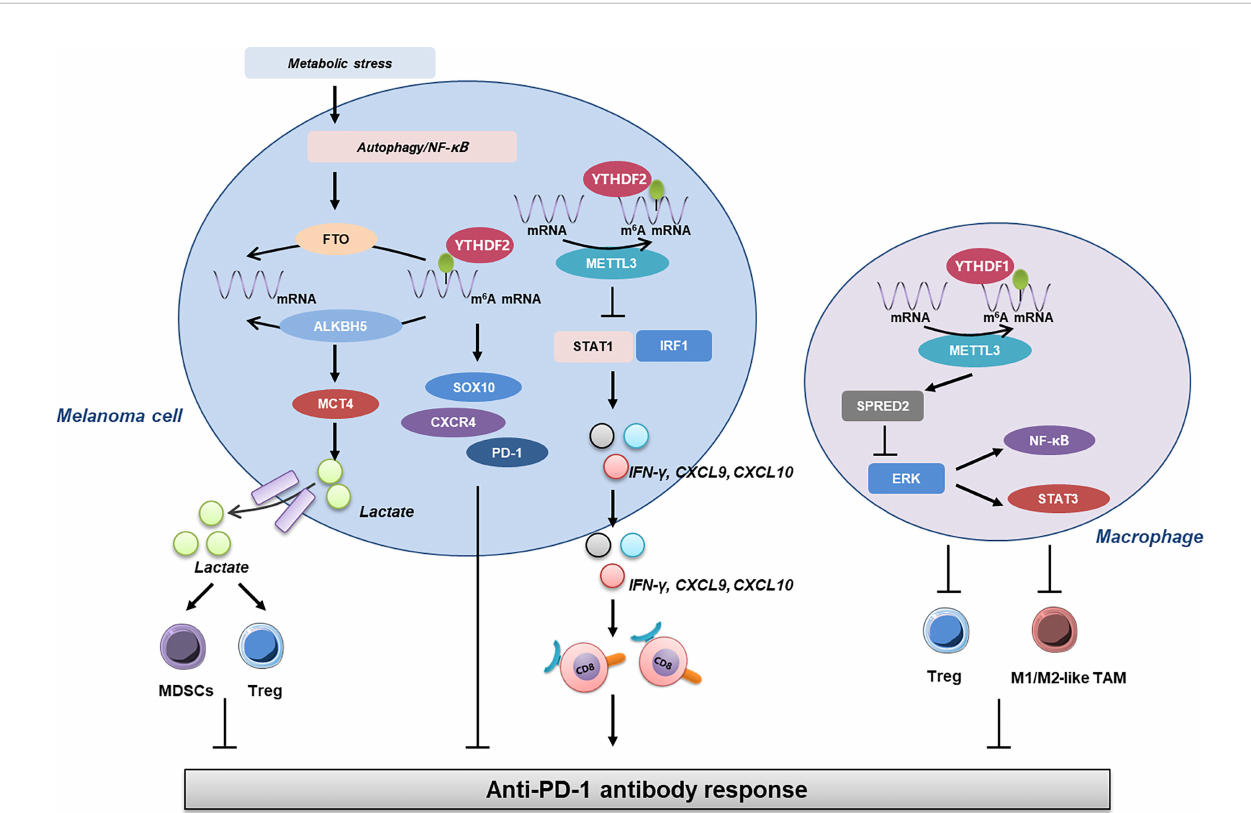
FIGURE 1 | The linkage between m 6 A RNA methylation and antitumor immunity in melanoma. Under metabolic stress, the expression of FTO is induced under the control of autophagy and NF- k B, which contributes to the increase of m 6 A RNA methylation and subsequent upregulation of SOX10, CXCR4, and PD-1, leading to impaired response to anti-PD-1 antibody. Furthermore, ALKBH5 modulates MCT4 expression and lactate content in TME, so the composition of tumor-in fi ltrating Tregs and MDSCs is altered to affect the outcome of anti-PD-1 immunotherapy. In addition to this, METTL3 exerts its role in tumor immunology in either melanoma cells or macrophages. The de fi ciency of METTL3 in melanoma cells promotes the expressions of STAT1 and IRF1, resulting in the increase of IFN- g , CXCL9, and CXCL10, which are critical for the in fi ltration and activation of CD8 + T cells. On the other hand, METTL3 in macrophages can impact the activation of ERK and downstream NF- k B and STAT3 via SPRED2, which then regulates the in fi ltration of Tregs and M1/2-like TAM and ultimately the response to anti-PD-1 antibody. FTO, fat mass and obesity-associated protein; TME, tumor microenvironment; Tregs, regulatory T cells; MDSCs, myeloid-derived suppressor